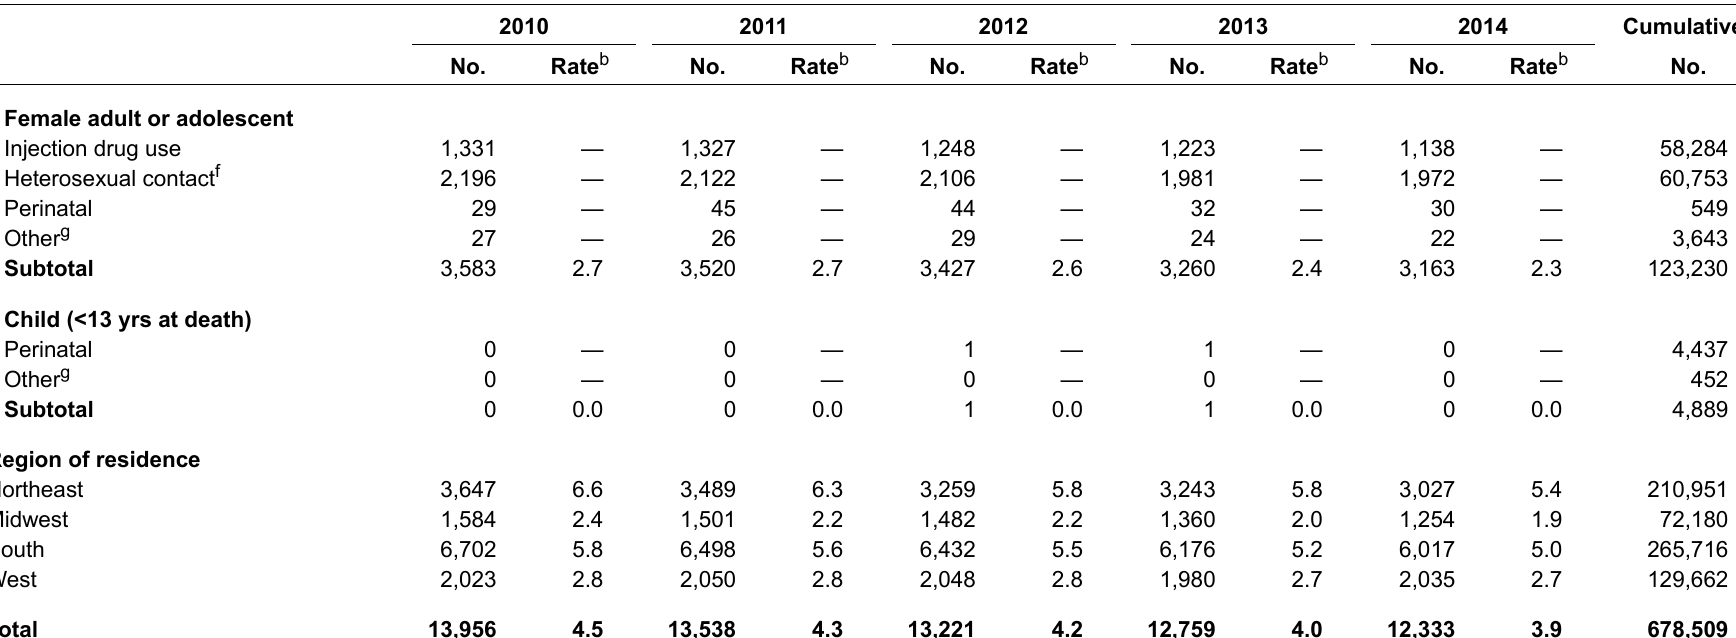
Table 13a. Deaths of persons with diagnosed HIV infection ever classified as stage 3 (AIDS), by year of death and selected characteristics, 2010–2014 and cumulative—United States